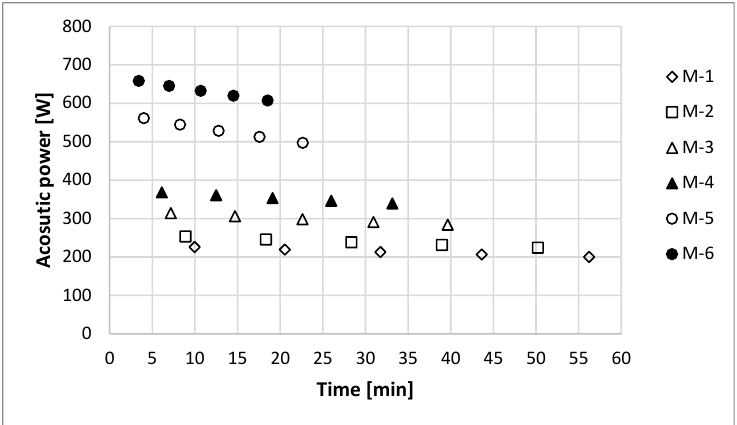
Figure 3. Acoustic power evolution during the UAE of polyphenols at medium scale. Pressurized tests (full), non-pressurized (empty).